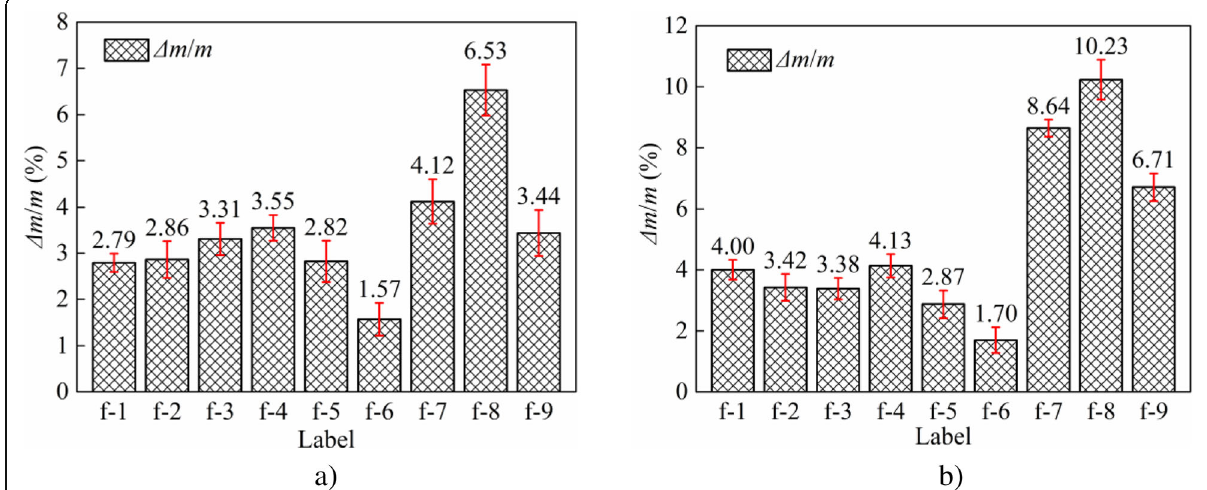
Fig. 5 Mass change of SCGAAC subjected to a different number of freeze-thaw circles: a) after 25 freeze-thaw cycles; and b) after 50 freeze-thaw